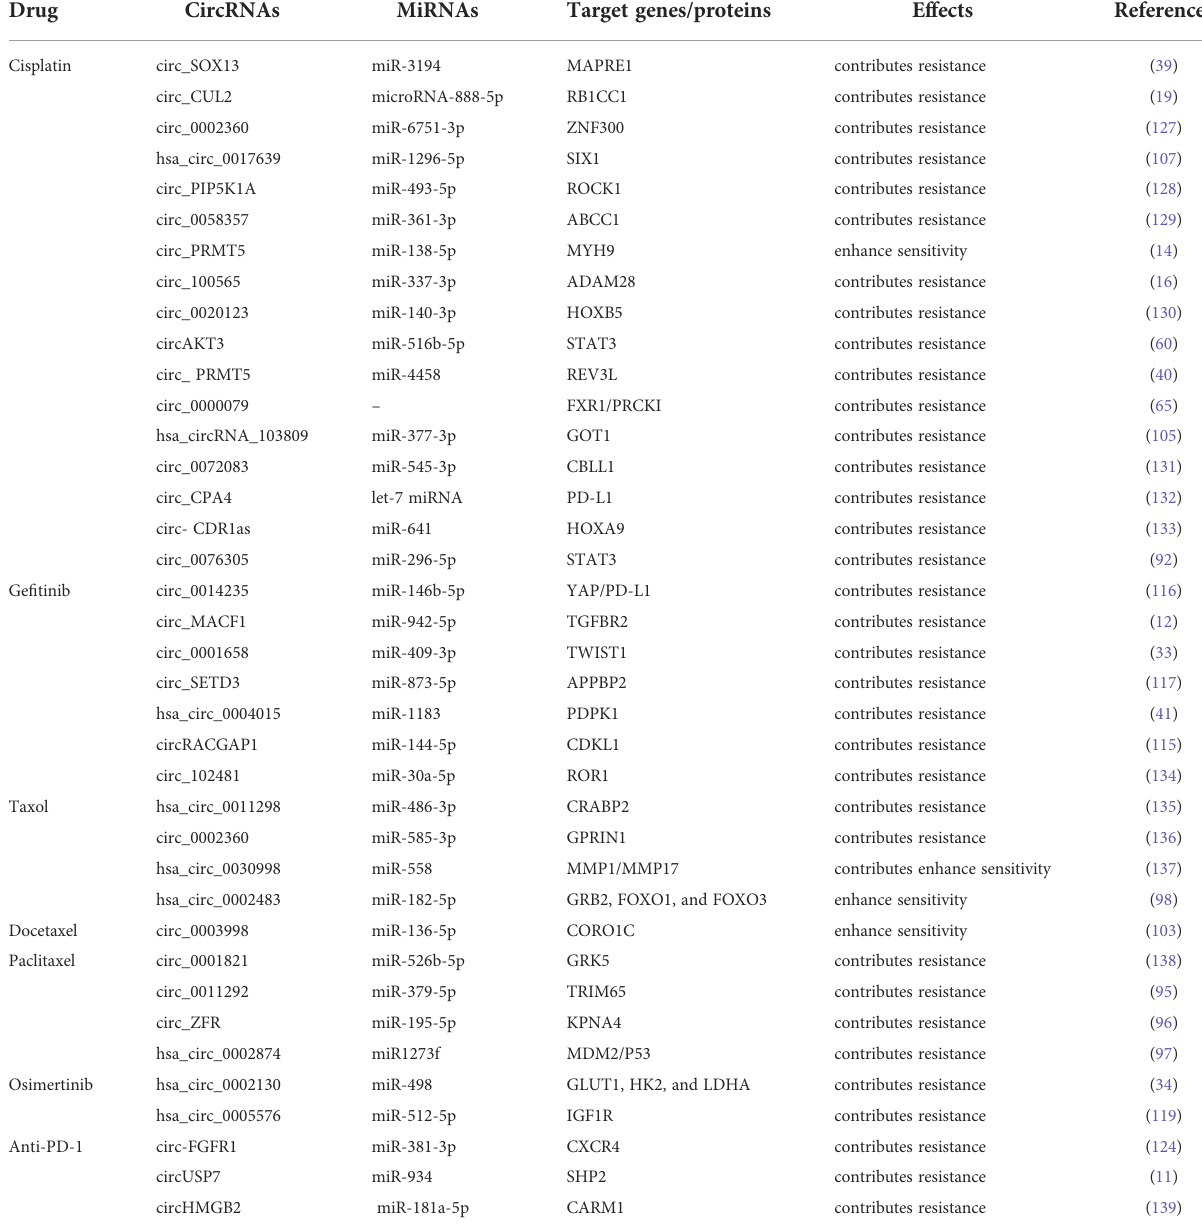
TABLE 2 circRNAs function as miRNAs sponge in drug resistance of lung cancer. Drug CircRNAs